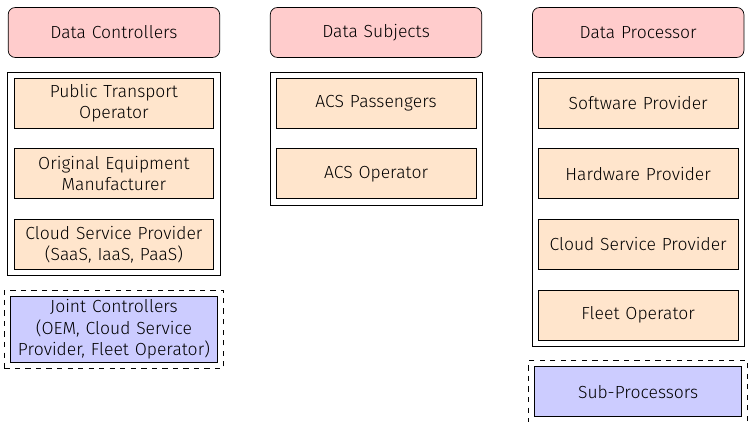
Figure 3. ACS’s stakeholders classification per the GDPR